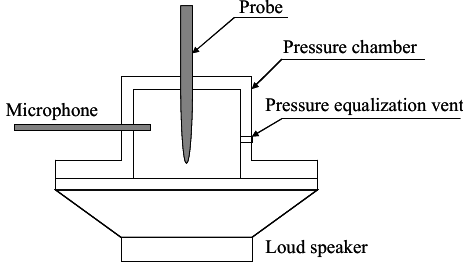
Fig. 6 Frequency response measurement apparatus.